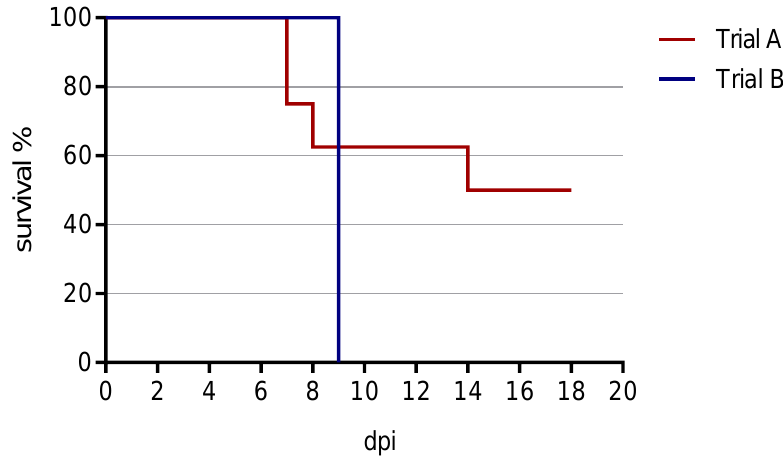
Figure 3. Survival curve from both animal trials. In trial A, four out of eight pigs survived until the end of the experiment at 18 dpi. In trial B, all animals were euthanized by 9 dpi (reaching the hu-